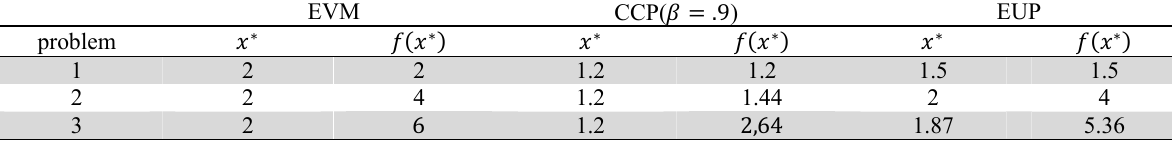
Comparison of EVM, CCP and EUP EVM CCP( (cid:2010) = .9 )